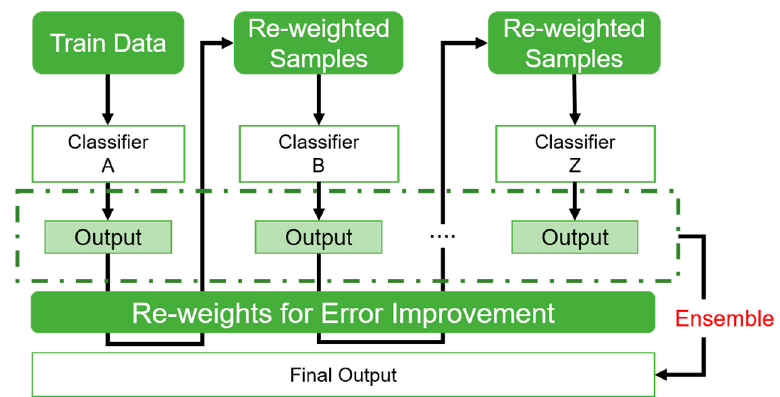
Figure 2. Boosting technique using adaptive weights.